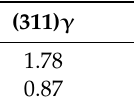
Figure 1. Heat treatment process of test steel. In the formula, G represents the lattice parameter correlation value of the FCC phase and BCC phase [12], and the detailed correspondence is shown in Table 2. Vi is the volume fraction of reversed austenite corresponding to different G values, I γ is the integral intensity of the (200), (220), and (311) crystal plane diffraction peaks of the FCC phase, and I α is the integral intensity of the (200) and (211) crystal plane diffraction peaks of the BCC phase. The texture of the samples was also measured using an X-ray diffractometer. The ODF cross section was characterized using the Roe method, and the content of each texture component was calculated using the texture analysis software ResMat-TexTools. Table 2. G values corresponding to different crystal face